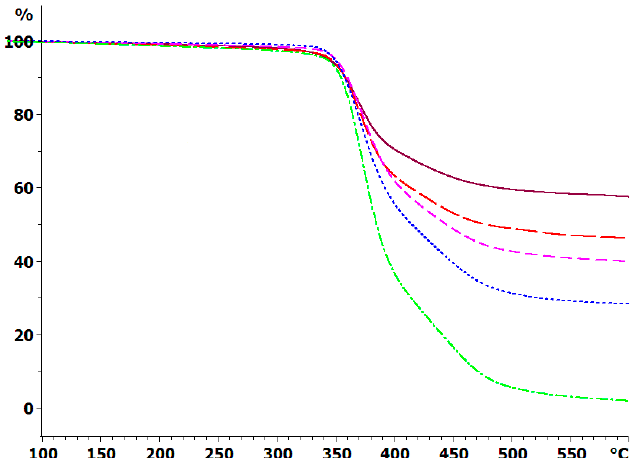
Figure 8. TGA curves of sample mass versus temperature for the fully cured ETLBN30- y system at 10 K / min in an inert atmosphere: dash-dotted, green, y = 0; dotted, blue, y = 30; short dash, pink, y = 50; long dash, red, y = 60; full line, purple, y = 70.